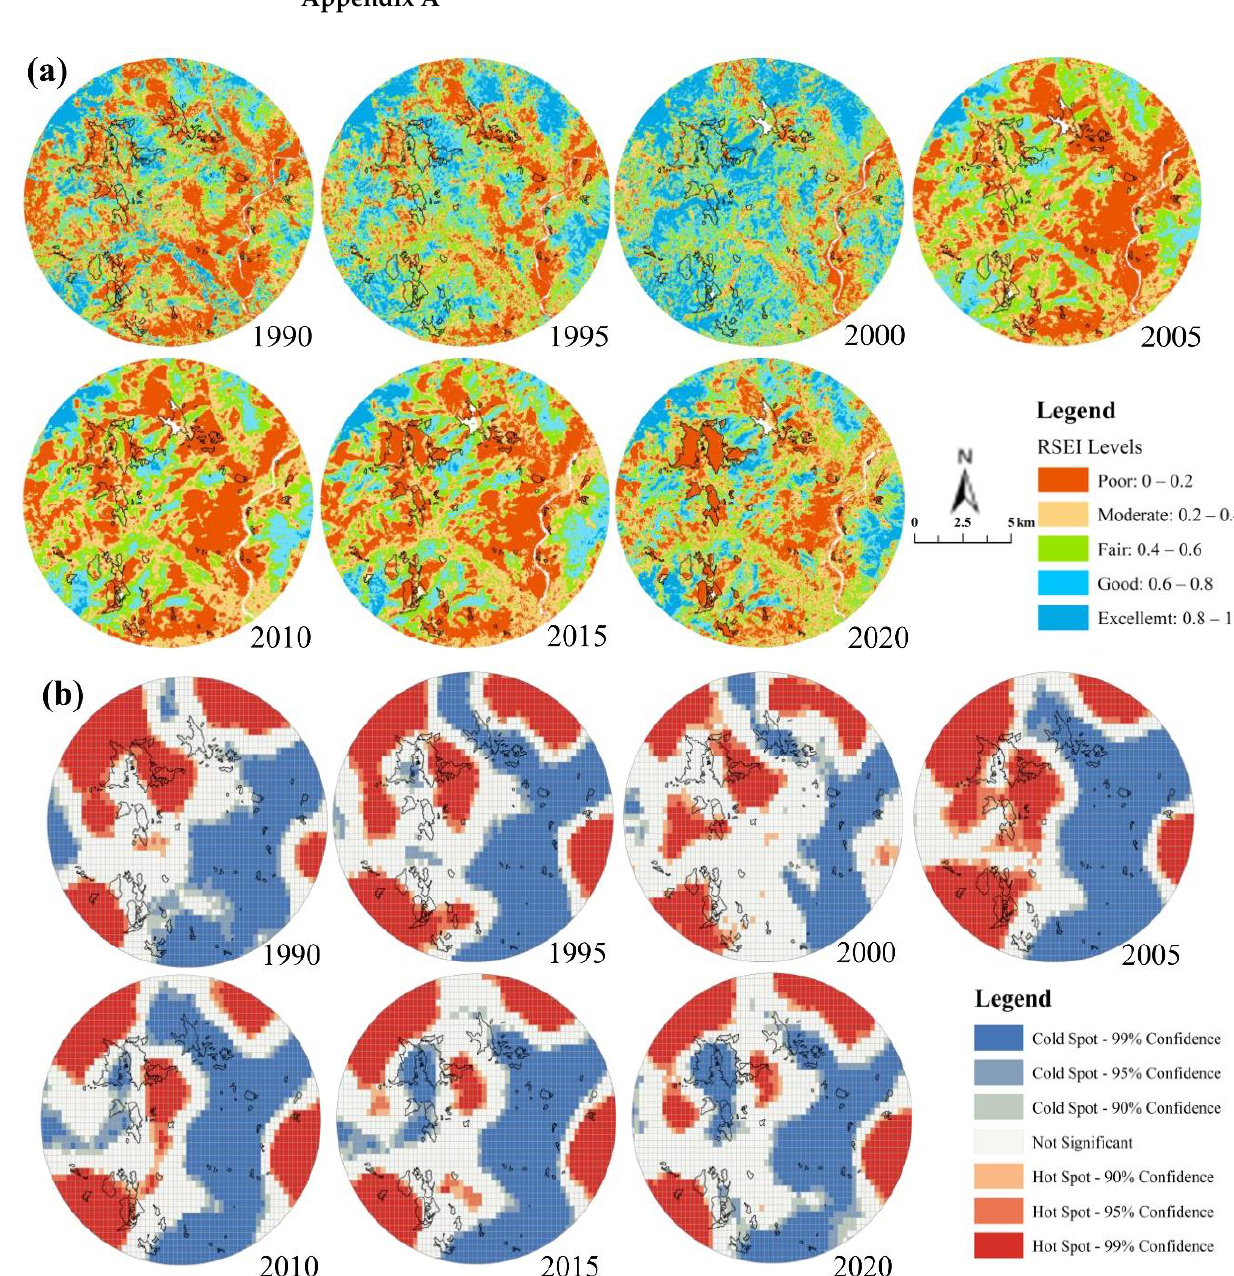
Figure A1. Spatial Distribution of RSEI and Hotspots and Coldspots in Baima Mine (( a ): Spatial Distribution of RSEI, ( b ): Spatial Distribution of Hotspots and Coldspots).